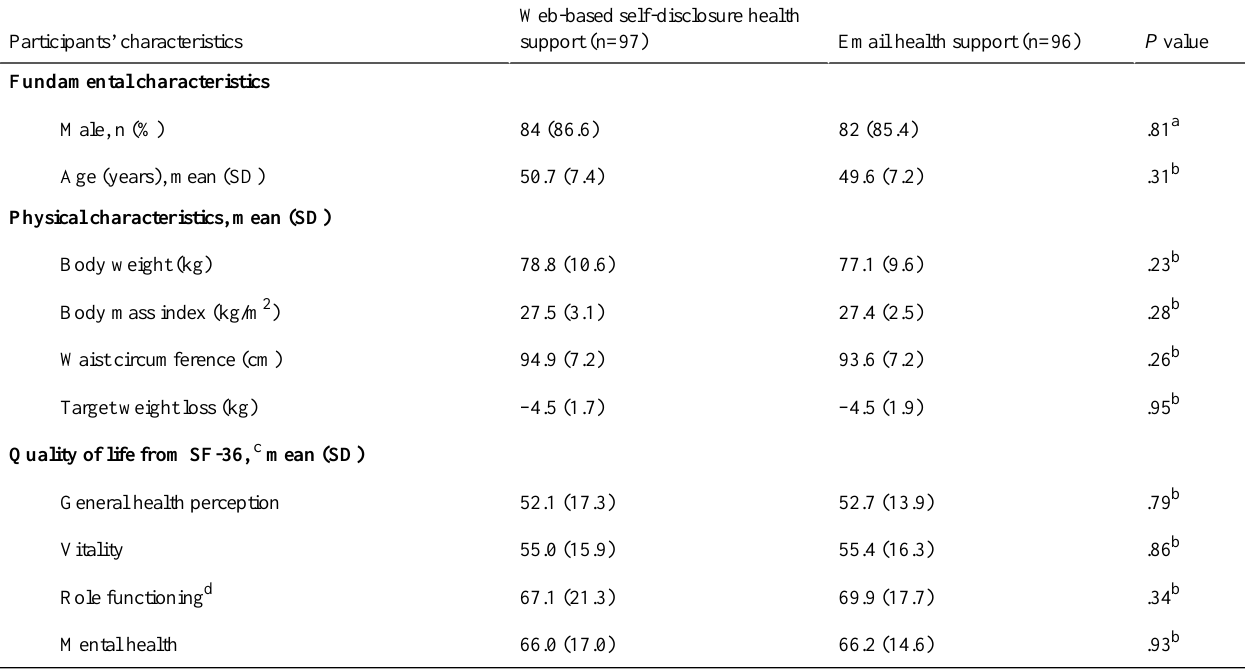
Table 1. Baseline characteristics of participants